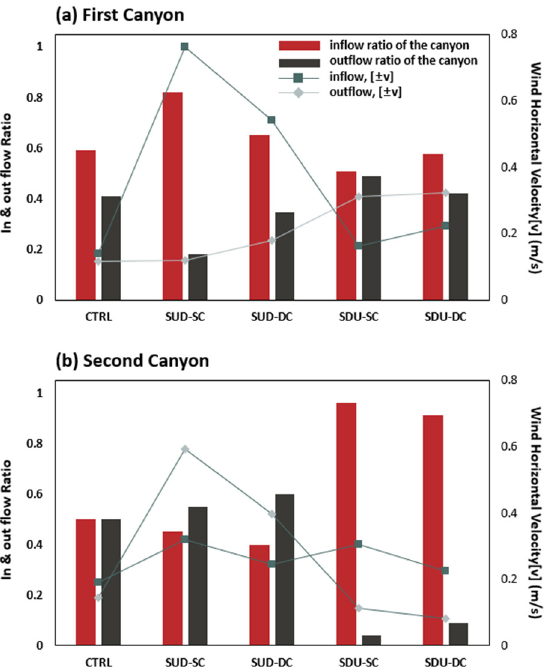
Figure 11. Changes in wind field direction of the inflow and outflow for the in-canyon region with wind horizontal velocity in the ( a ) first canyons and ( b ) second canyons.